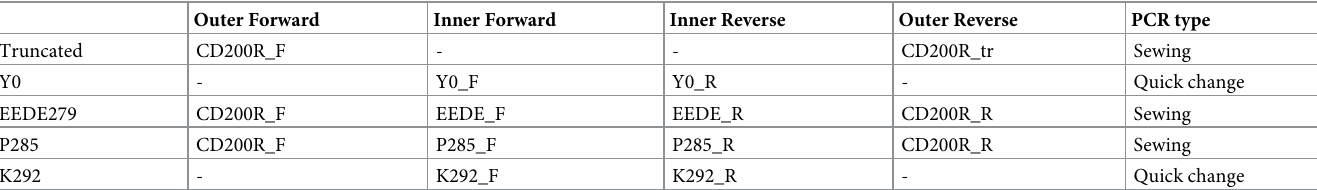
Table 1. Schematic representation of primers used for mutagenesis.